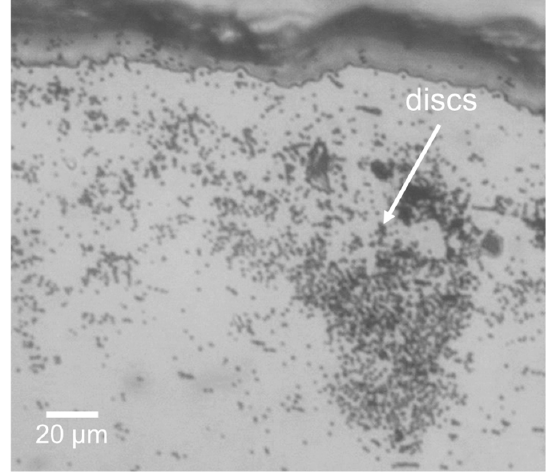
Figure 6. Example image of magnetic microdiscs captured from a 100 mL sample at 120 µL/s using the µFMS device.